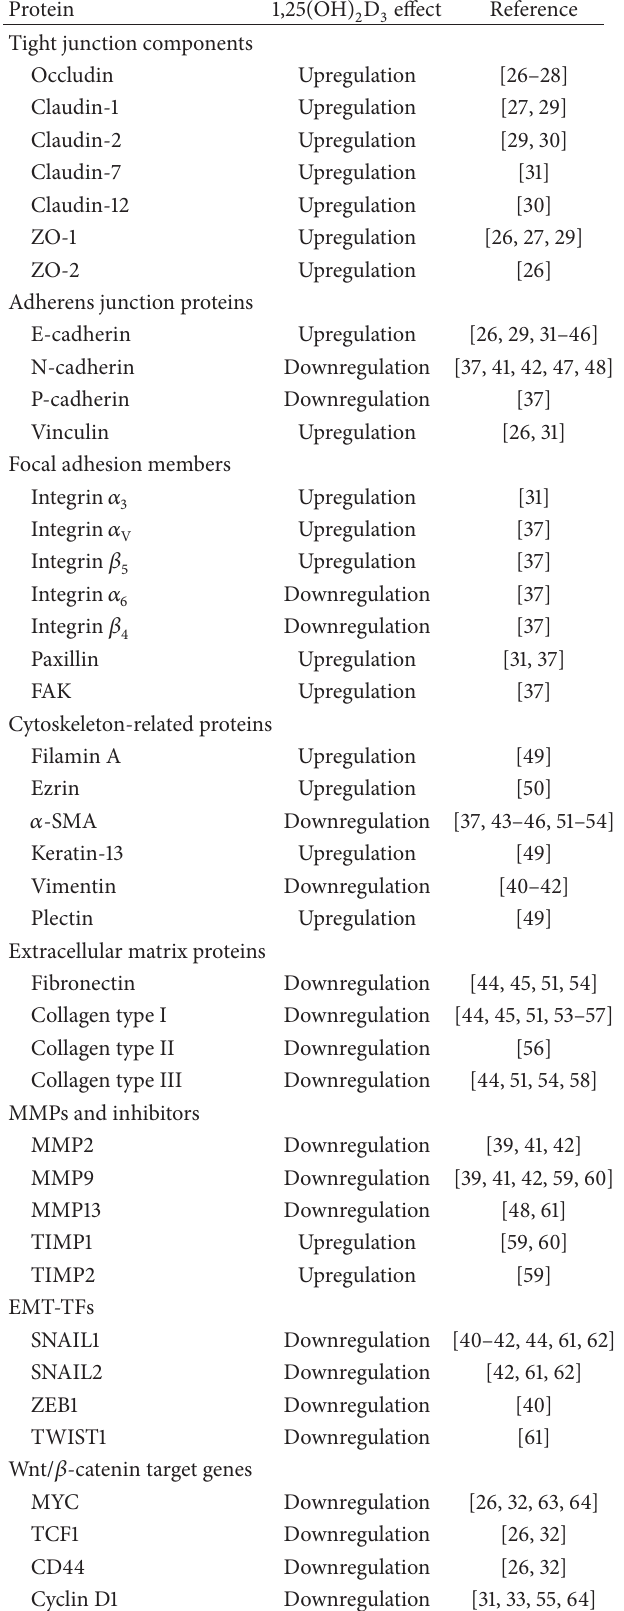
Table 1: List of 1,25(OH) 2 D 3 -regulated proteins involved in EMT. Protein